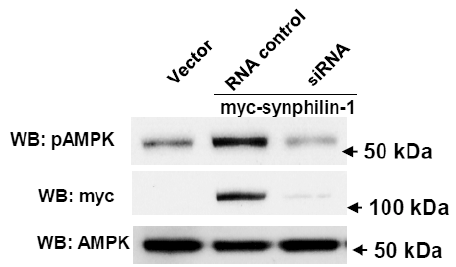
Figure 4. Knockdown of synphilin-1 reduced AMPK phosphorylation. Cells expressing synphilin-1 or vector were transiently transfected with siRNA targeting human synphilin-1 for three days. The cell lysates were subjected to Western blot using anti-myc, anti-phospho-AMPK α , and anti-AMPK α antibodies. Representative blots from three separated experiments.